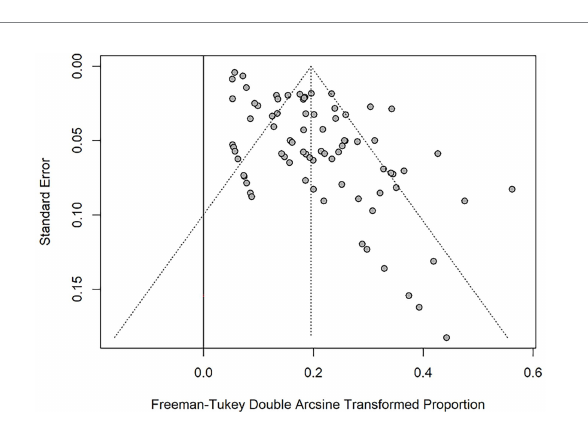
FIGURE 6 Funnel plot for the Freeman-Tukey Double Arcsine Transformation proportion of PPM across all